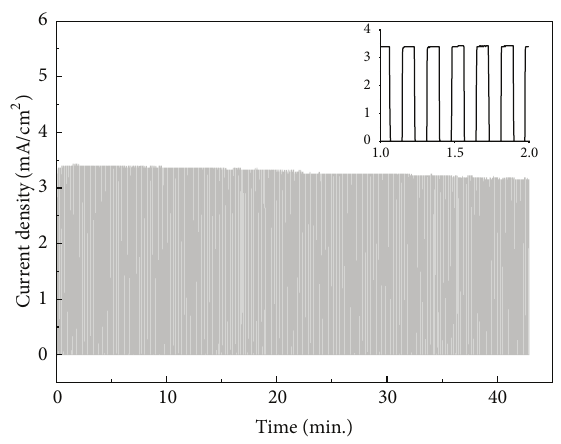
Figure 10: Current in time for an uncoated CdS sample in Na 2 SO 3 electrolyte at 0.5 V versus Ag/AgCl.